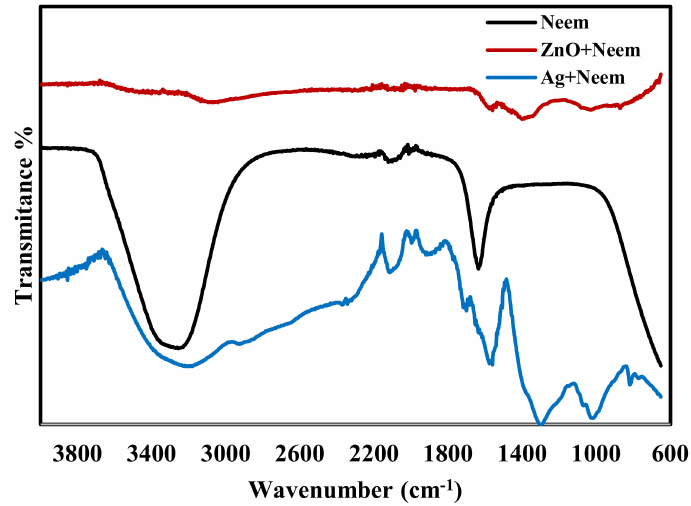
Figure 2. FTIR spectra of pure neem leaf extract, Neem extract mixed with Zn(NO 3 ) 2 solution and neem extract mixed with AgNO 3 solution.